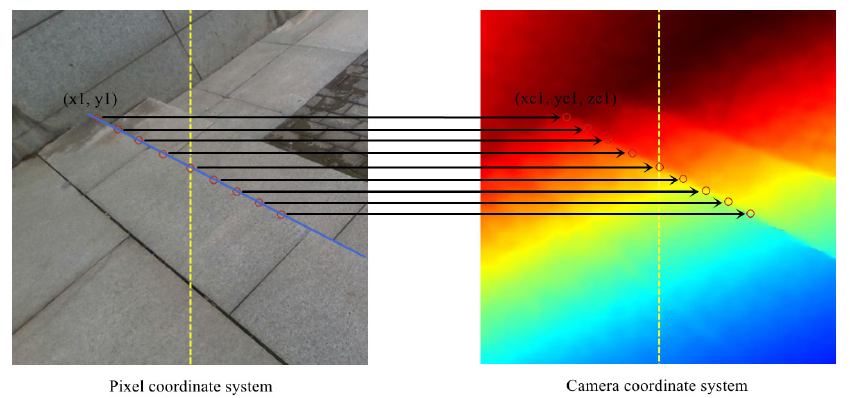
Figure 5. The transformation of stair sampling points. Taking the left endpoint of the stair line as an example, its coordinates in the pixel coordinate system are (x1, y1). Using the aligned point cloud data, its corresponding camera coordinates (xc1, yc1, zc1) are obtained, and the remaining sampling points are the